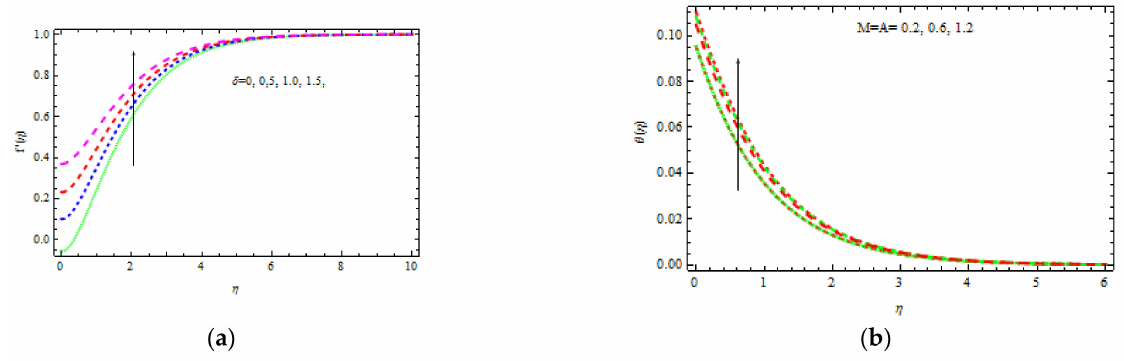
Figure 6. Inspiration of δ ( a ) and M and A ( b ) on velocity and temperature, respectively.